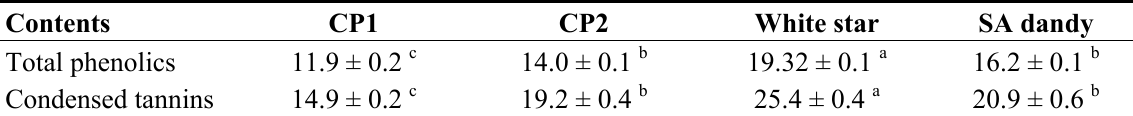
Table 1. Contents of total phenolics and condensed tannins (mg/g) of the extracts of cowpea seeds.